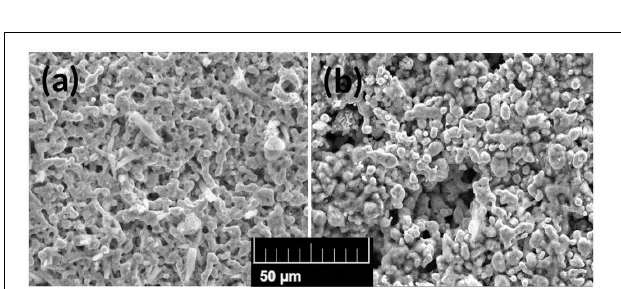
FIGURE 5 | SEM micrographs of the spent NiO oxygen electrodes at two different magnifications: (a–c) electrode structure of the reverse MCFC cell; (b–d) electrode structure of the reference test cell.